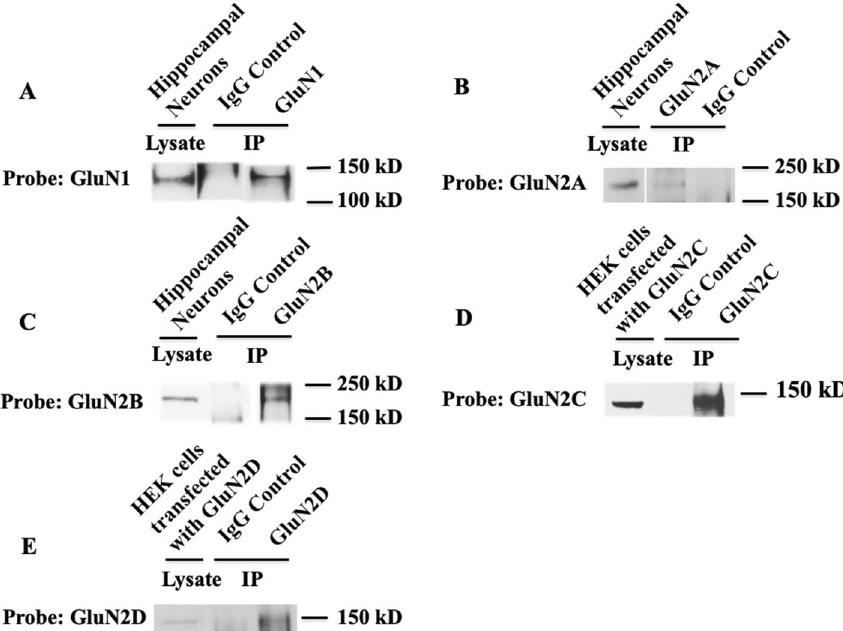
Figure 4. Full-length NMDA receptors are expressed by cultured HPASMCs. Cultured HPASMCs were lysed and immunoprecipitated with GluN1- or GluN2- subunit specific antibodies or control non-immune IgG, and the pellets were analyzed by Western blot. Immunopositive bands containing full-length GluN1 ( A ) and GluN2 (2A–D) ( B – E ) protein were detected in immune pellets from lysates of PASMCs but not in the IgG control conditions studied in parallel. Cropped images are shown for conciseness. Full-length blots are represented in Supplementary Fig. S9. Results are representative of three separate